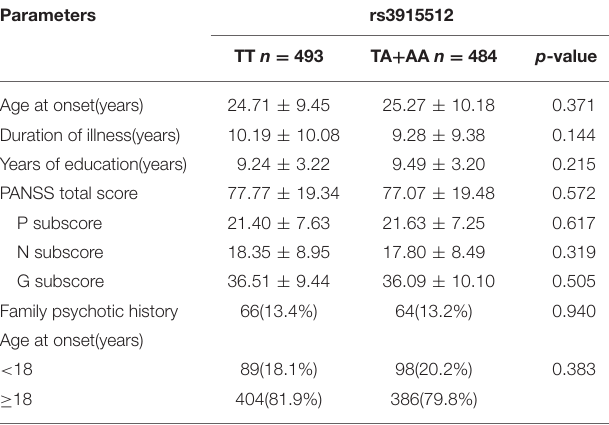
Values are the mean ± SD; PANSS, Positive and Negative Syndrome Scale.